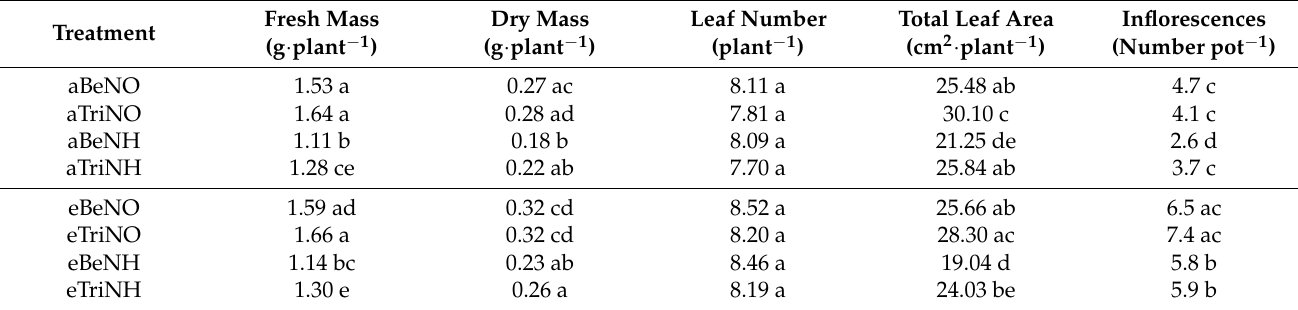
Table 2. Above-ground biomass parameters at harvest. Data are averages of n = 3. Treatment